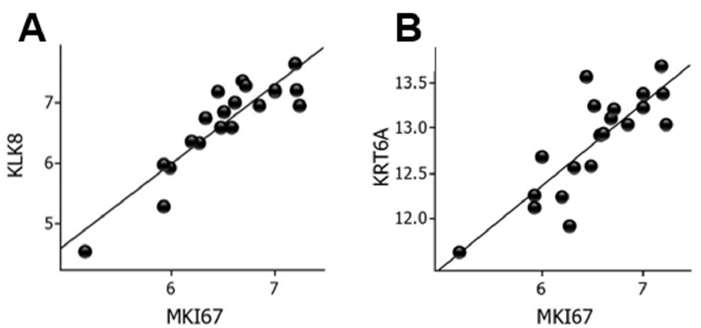
Figure 5. Correlation between MKI67 and KLK8 mRNA levels ( A ) and between MKI67 and KRT6A mRNA levels ( B ) in wounds. Log2-transformed expression values are shown on the y- and x-axes. KLK, kallikrein; KRT, keratin.